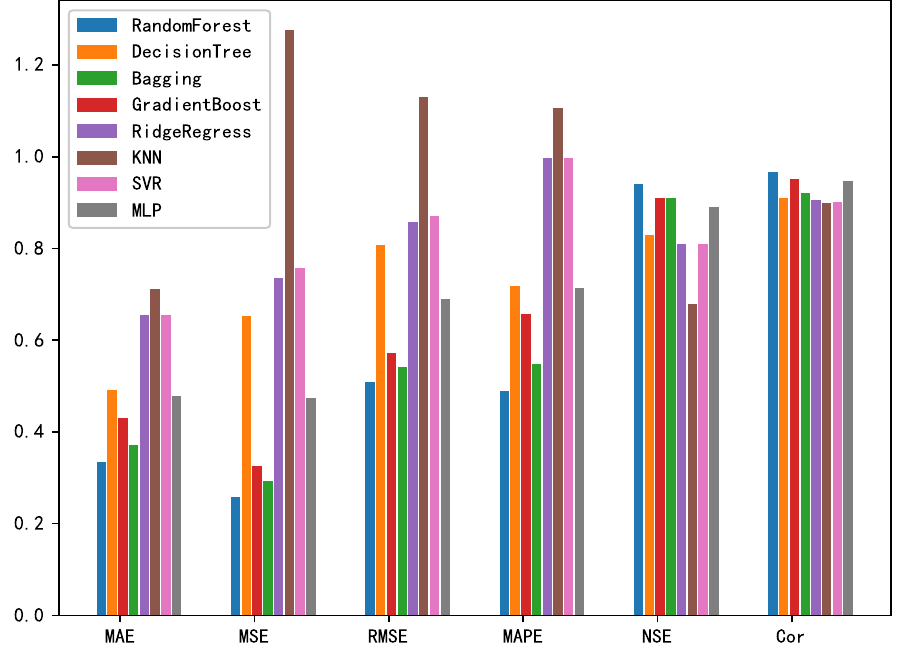
Figure 10. Performance histograms of different